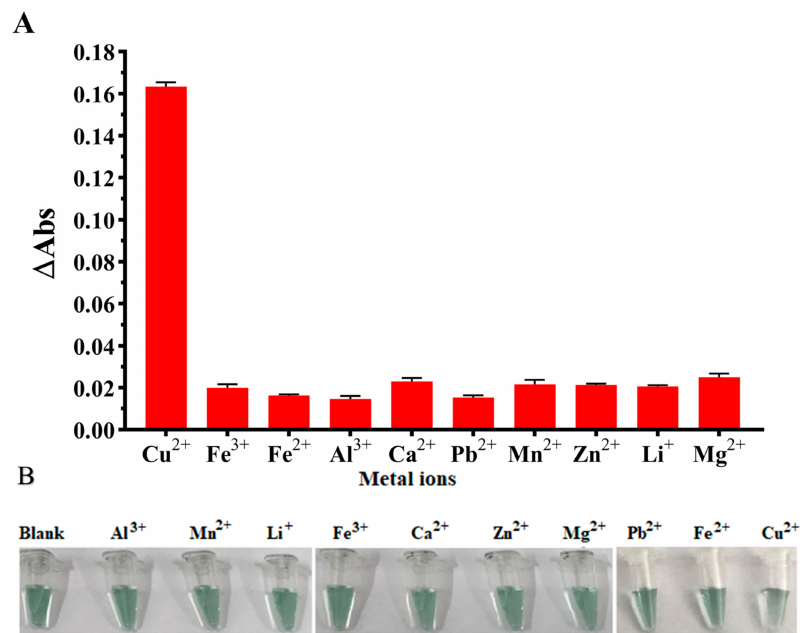
Figure 4. Selectivity of the Cu 2+ sensor system. ( A ) the change of absorbance ( ∆ Abs) of the turn-off sensor after adding different metal ions. ( B ) The chromogenic results. The final concentrations of the different metal ions are 10 mM.